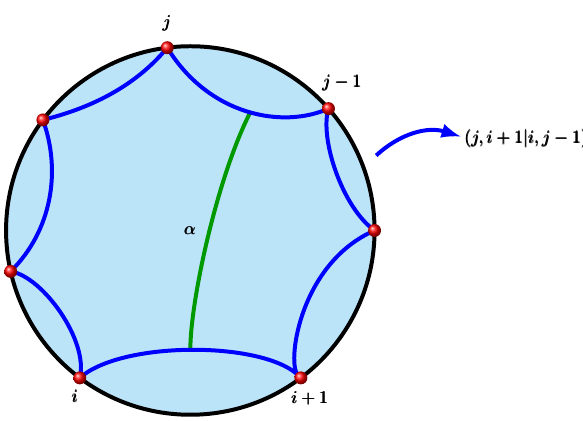
Figure 5 . The convex hull of several points is shown, the blue lines are its geodesic boundaries. The green line is the geodesic arc with the minimal length among those separating the particles in this